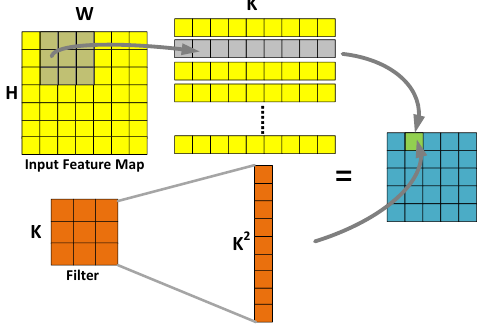
Figure 2. Calculation process of im2col .